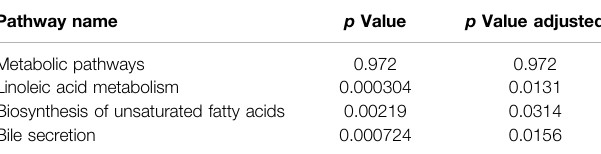
TABLE 2 | Pathways obtained among the control, CCl 4 , and the SCU group in feces samples. Pathway